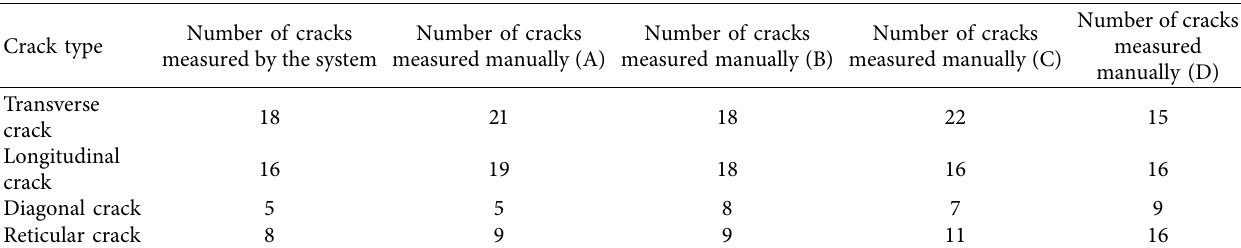
Table 8: Data table of the accuracy of the crack type identified by the